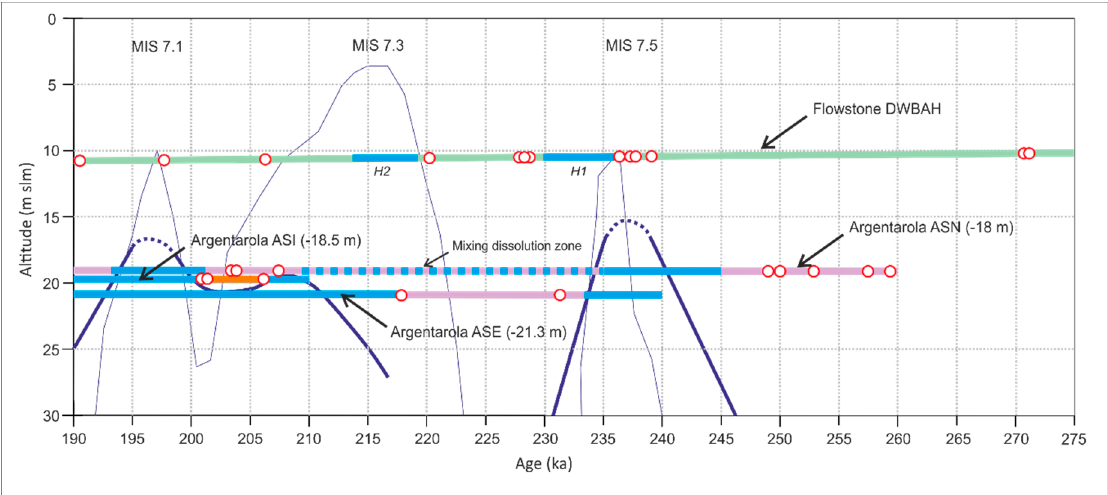
Figure 15. Zoom 2 of Figure 15. Green line: DWBAH flowstone [11]; orange line: Stalagmite ASN ( − 18 m) from Argentarola cave [22], and stalagmite ASI ( − 18.5) from Argentarola cave [2]; black line: global sea level curve reconstructed by [88]; dark blue line: sea level drown with observed data.